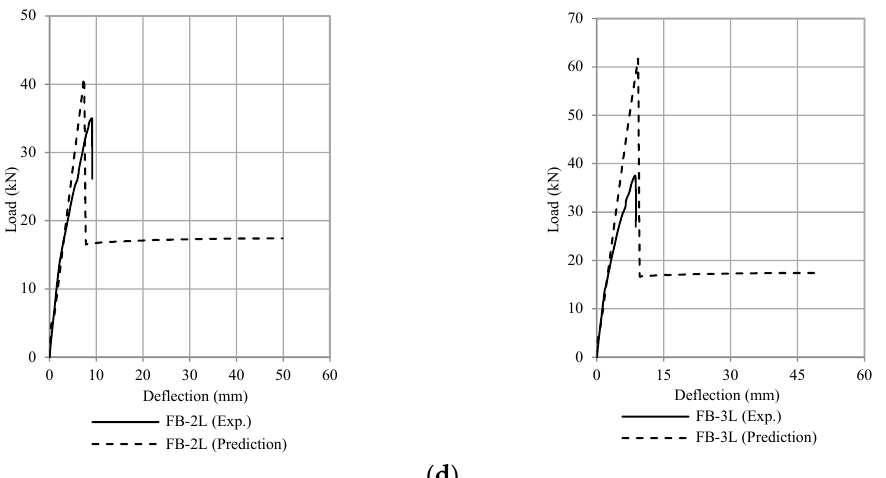
Figure 21. Comparison of the debonding load between the experimental results and the prediction (Type 3. debonding failure value is higher than the experimental debonding load) ( a ) Brena et al. [8], ( b ) Khomwan et al. [11], ( c ) Al-Tamimi et al. [14], and ( d ) Ahmed et al. [15].